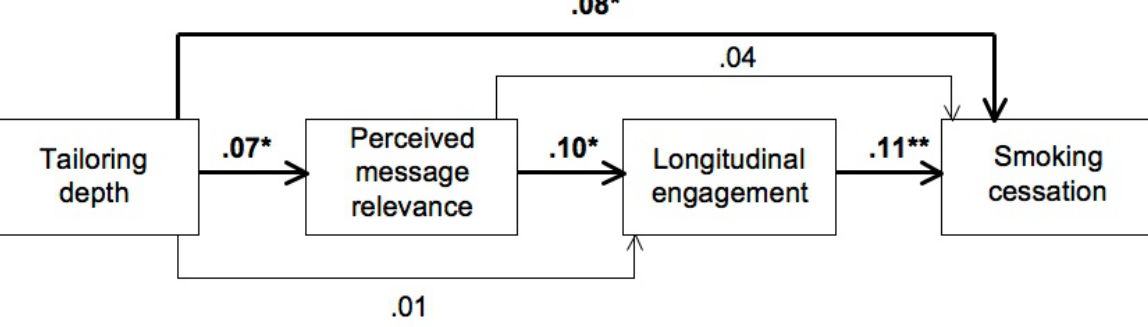
Weekly ExposureSingle Exposure